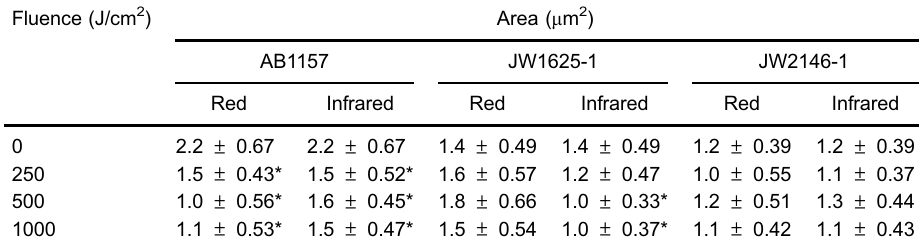
Table 6. Surface area of exponential E. coli cells exposed to red and infrared